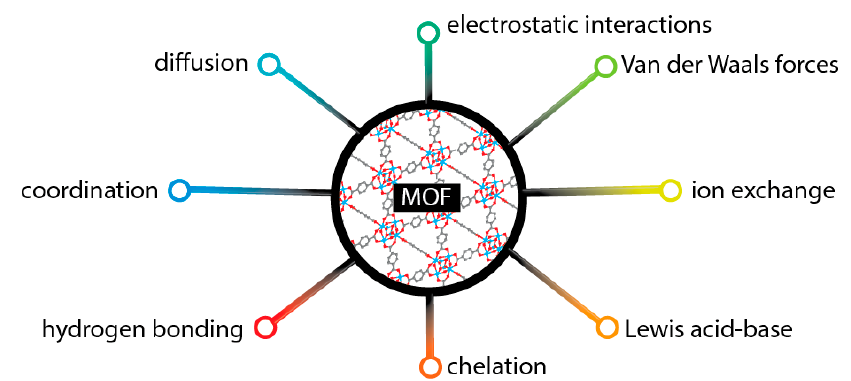
Figure 10. A schematic illustration of the interactions/mechanisms involved in the adsorption/extraction of organic compounds or metal ions by MOFs.